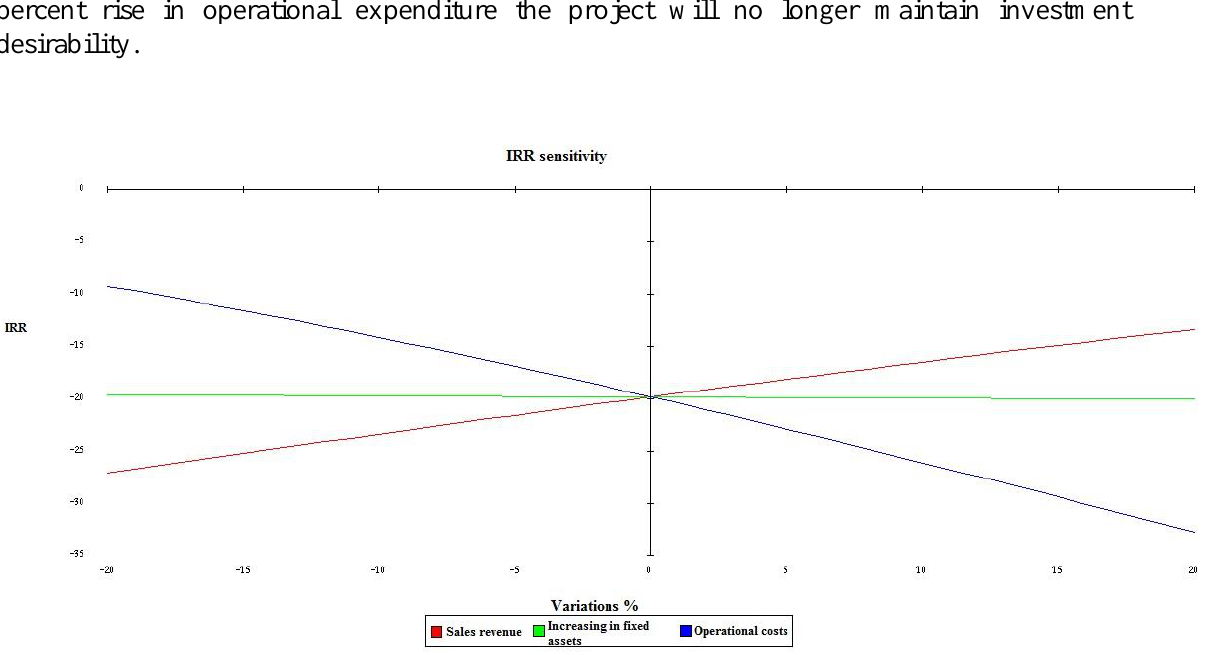
Figure 2. IRR Sensitivity (per one-tenth